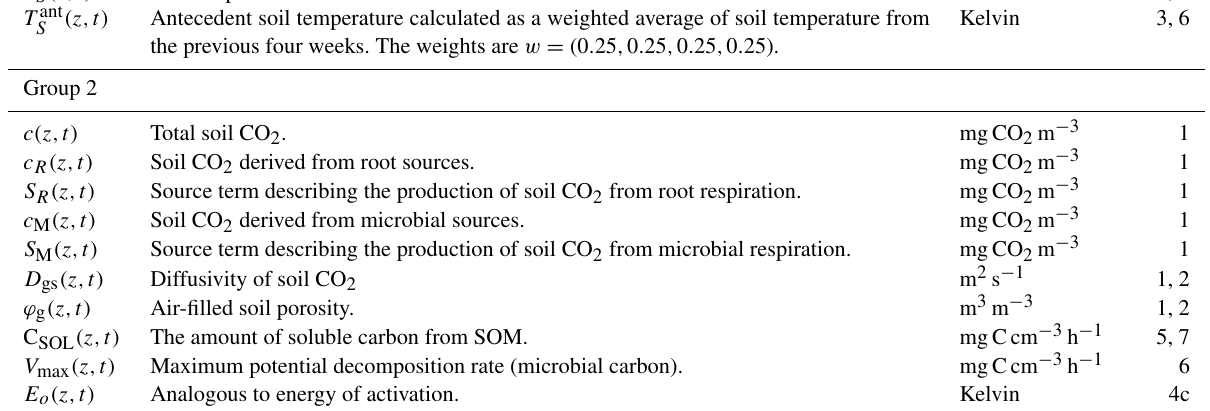
(Table 1) by trial and error to reflect the expectation that the effects of current soil moisture should be stronger for mi- crobial compared to root respiration because microbes tend to respond more rapidly to precipitation pulses (Risk et